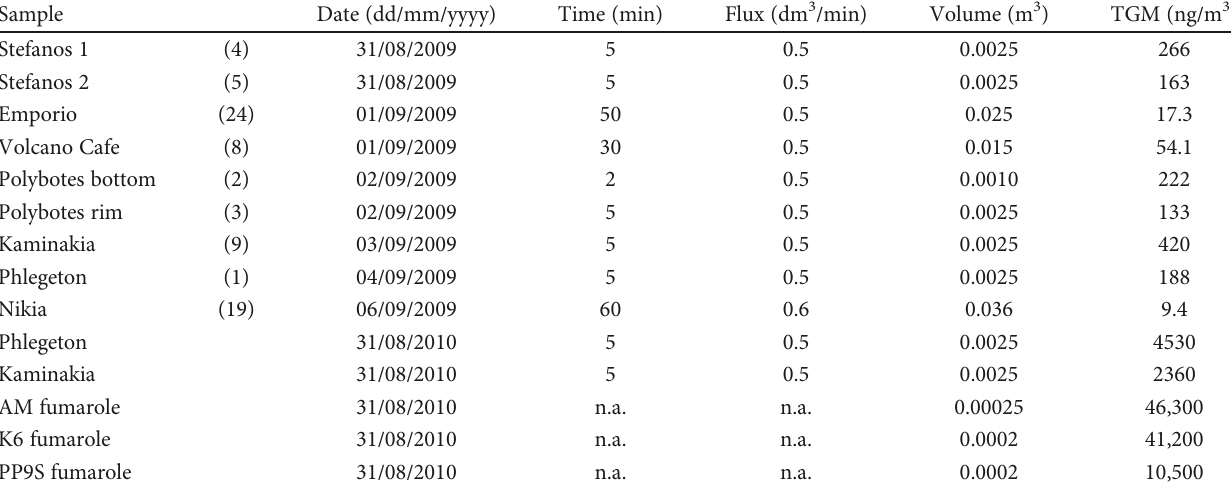
Table 1: Total gaseous mercury (TGM) measured with Au traps in the atmosphere and in hydrothermal fl uids at Nisyros. Sample